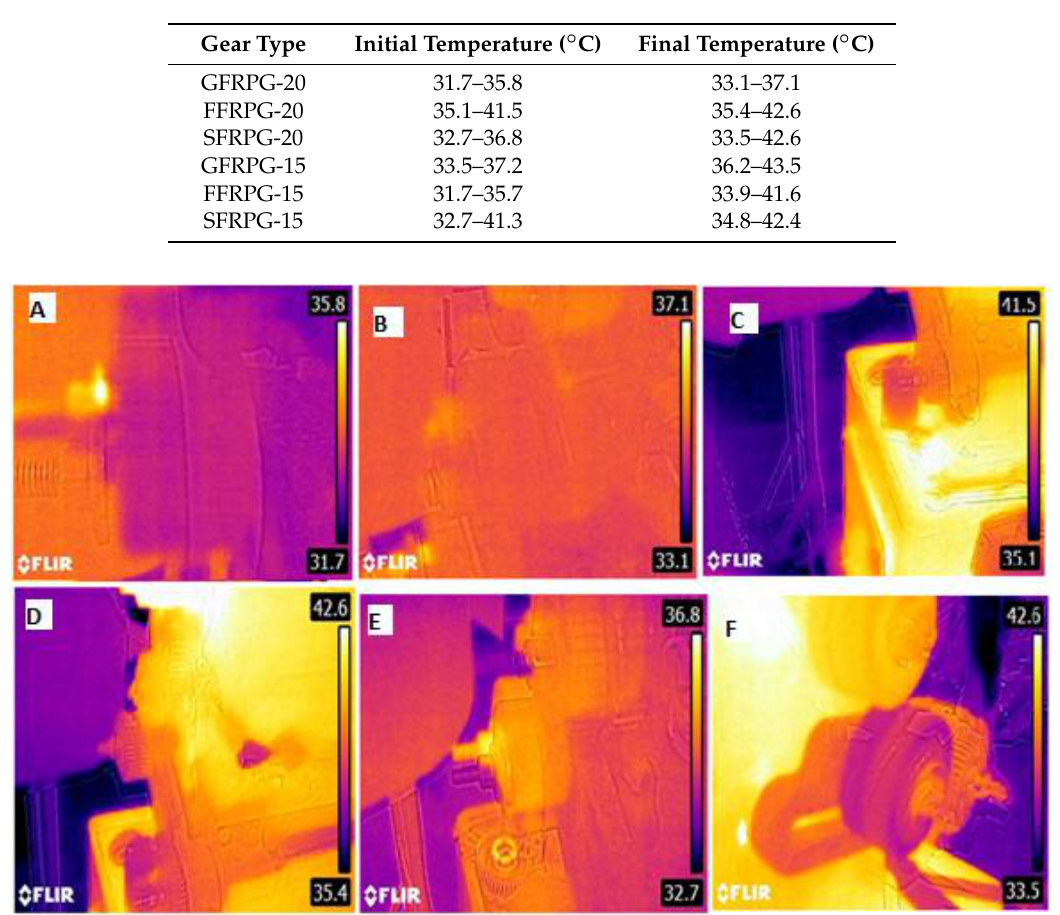
Figure 9. Thermal images. ( A ) Initial temperature of GFRPG-20. ( B ) Final temperature of GFRPG-20. ( C ) Initial temperature of FFRPG-20. ( D ) Final temperature of FFRPG-20. ( E ) Initial temperature of SFRPG-20. ( F ) Final temperature of SFRPG-20.